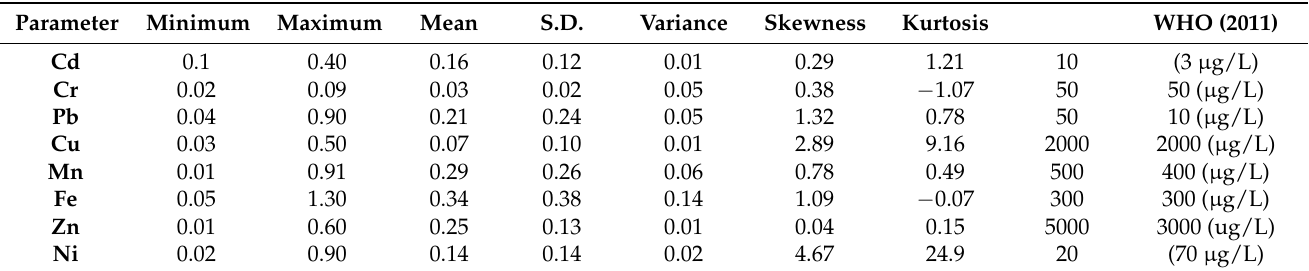
Table 2. Statistical analysis of heavy metals in groundwater samples collected in coastal region of Baluchistan,